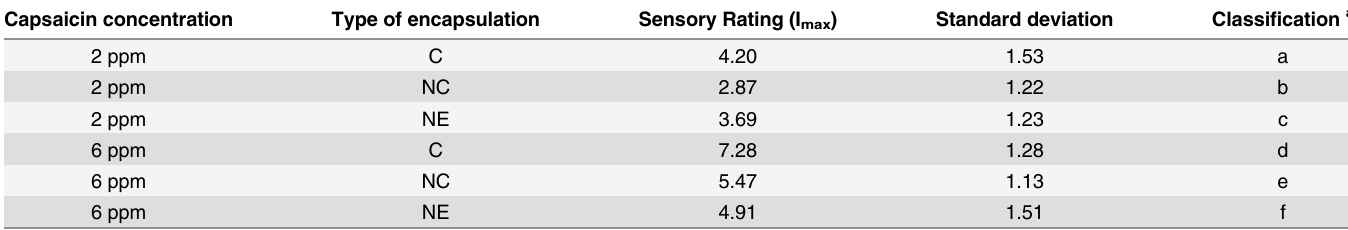
Table 4. Mean pungency ratings of the three kinds of